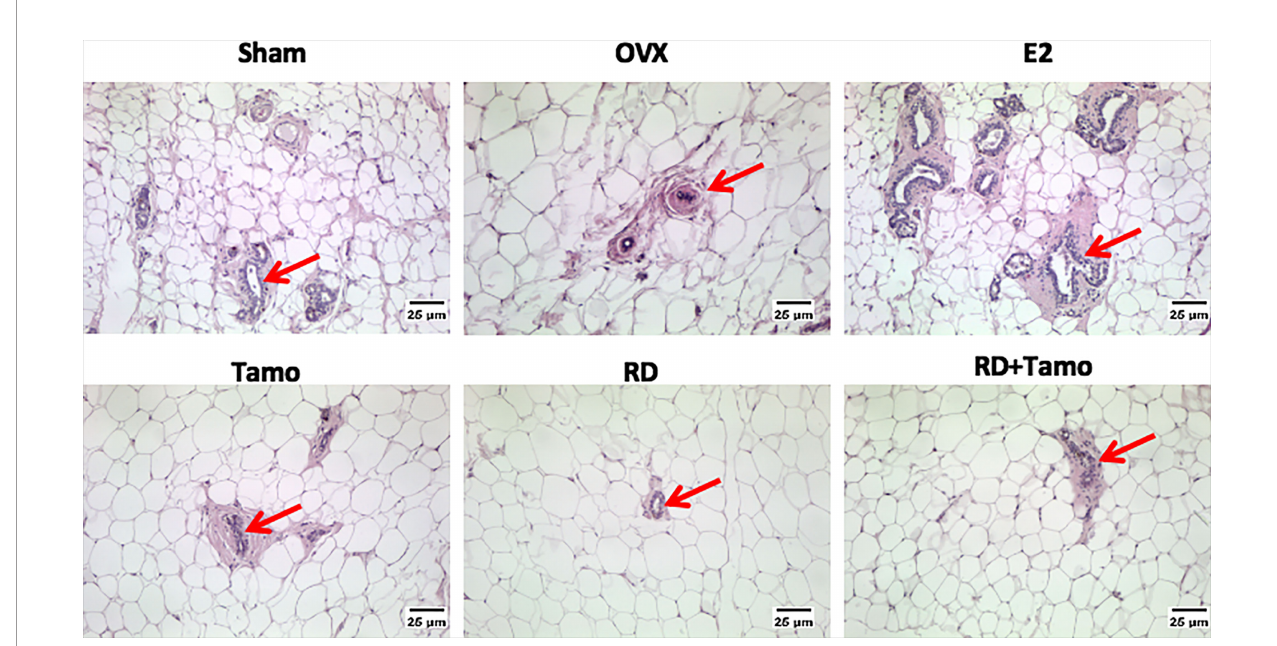
FIGURE 5 | Estrogenic effects of RD, tamoxifen, and their combinations on the morphology of breast tissue in mature ovariectomized rats. Upon treatment, breast tissue was collected in 4% paraformaldehyde and the morphology of mammary gland (as indicated by the red arrow, ×100) was visualized by H&E staining.